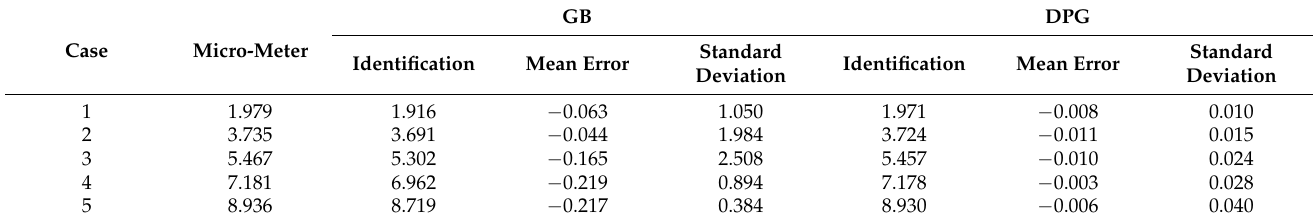
Table 4. Deflection identification at the micrometer 1 (units: mm).